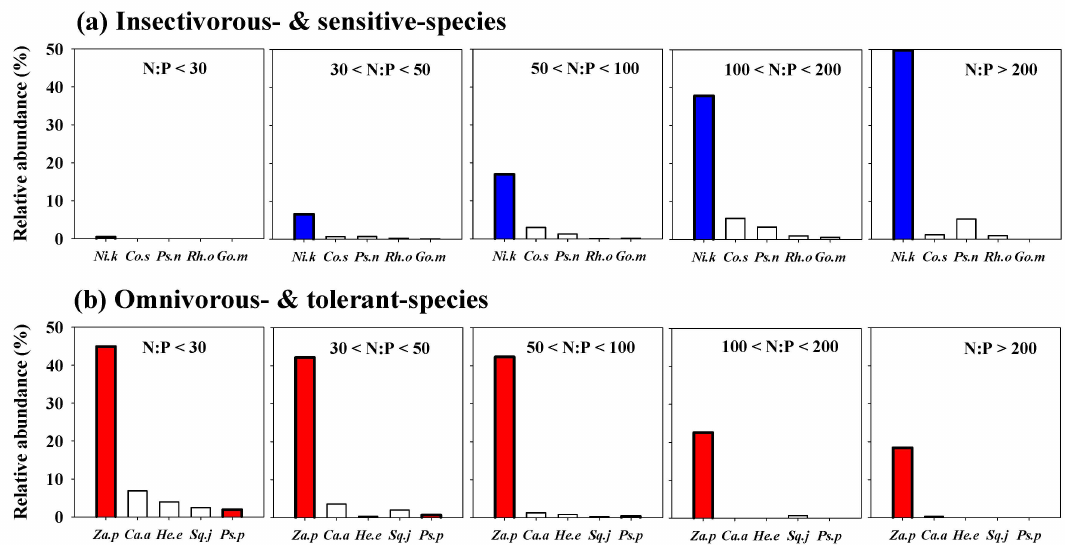
Figure 9. Mass ratios in the stream water of the N:P interval, plus the trophic composition and tolerance level of relative abundance (RA) (%). Upper panels indicate a combination of ( a ) insectivorous and sensitive species of RA (%); ( b ) omnivorous and tolerance species of RA (%). Pearson’s correlations of N:P ratios with RA (%) indicate a significant increase ( p < 0.05, r > 0; closed vertical blue bar: ( (cid:4) ), a significant decrease ( p < 0.05, r < 0; closed vertical red bar: ( (cid:4) ), and no significant change ( p > 0.05; opened vertical bar: ( ˝ ). Abbreviations: Za.P, Zacco platypus; Ca.a, Carassius auratus; He.e,